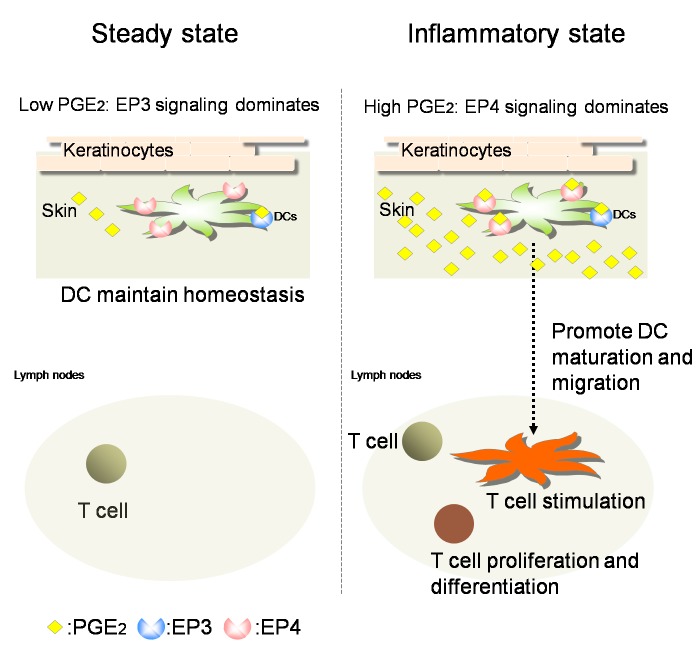
Hypothesis of the dual roles of PGE2 on cutaneous DCs.In the steady state when the concentration of PGE2 is low, endogenous PGE2 binds to EP3 preferentially (binding affinity of PGE2 to EP3 is higher than EP4), resulting in the prevention of impetuous immune responses to innocuous stimuli. On the other hand, in the inflammatory state, abundant PGE2 is produced by keratinocytes. High expression of PGE2 binds to EP4, which overcomes the inhibitory effect of EP3 signaling and promotes the maturation and migration of cutaneous DCs to initiate skin immune responses.